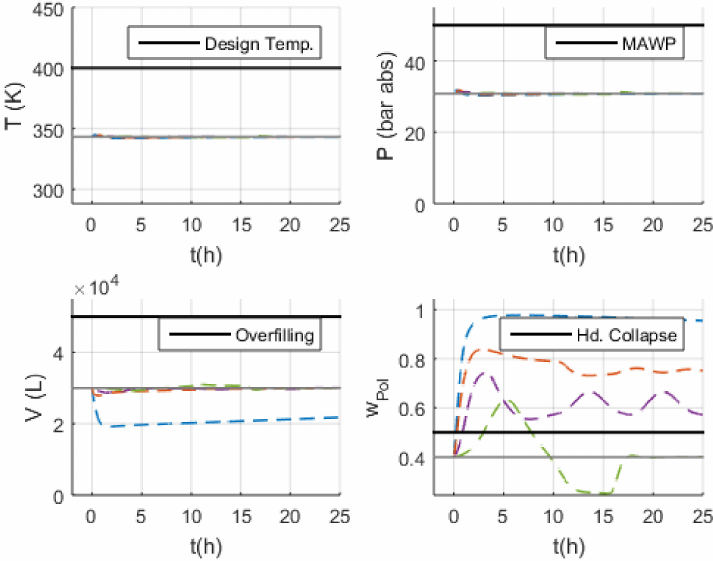
Figure 14. Behavior of critical variables in scenarios S-1 and S-2 with Model 3. Make-up flow: ( ) no flow; ( ) 50% of normal flow; ( ) 90% of normal flow; ( ) 99% of normal flow; ( ) normal.